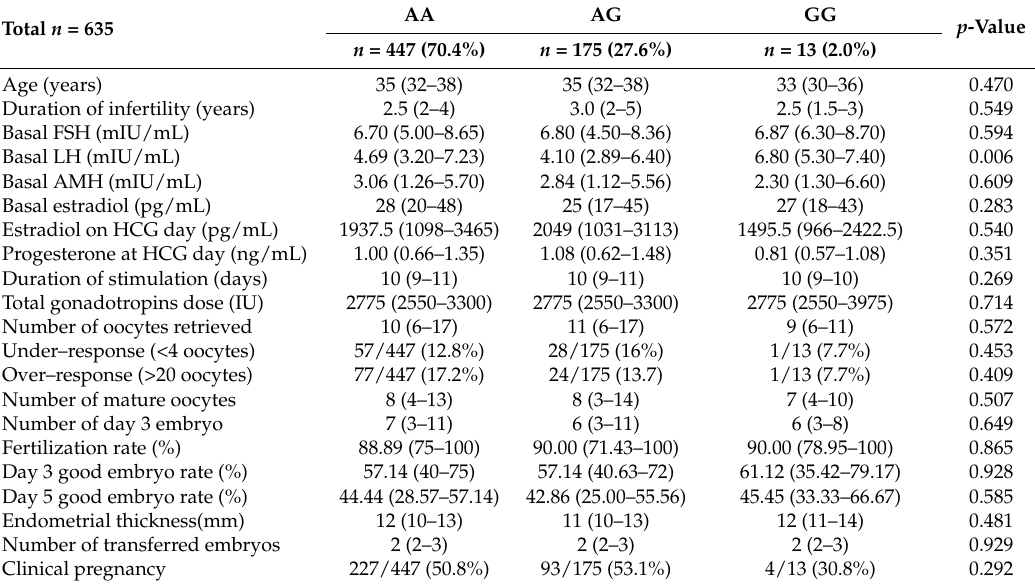
Table 2. Baseline characteristics and IVF treatment cycle outcomes of patients with different AMHRII − 482 A > G (rs2002555)